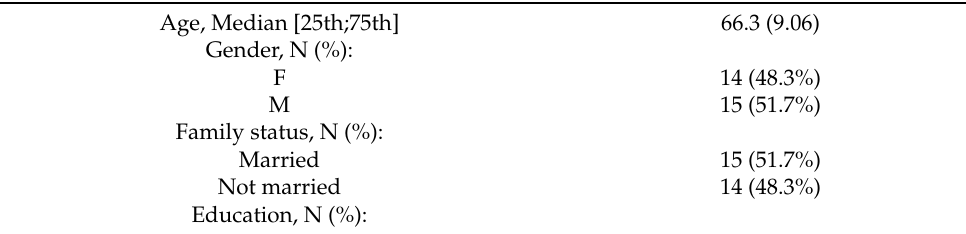
Table 1. Demographic variables distribution, N =